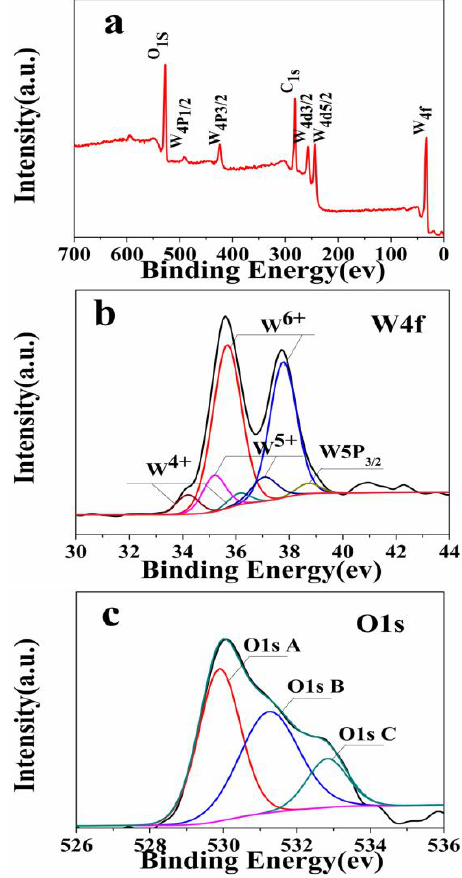
Figure 4. X-ray photoelectron spectroscopy (XPS) spectra of the products prepared at 12